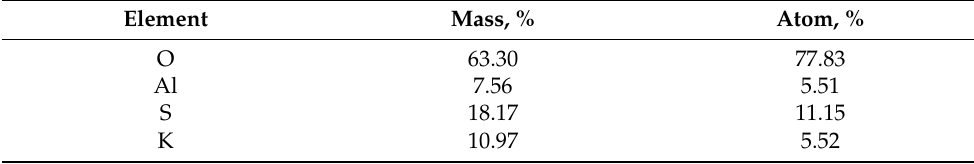
Table 2. EDX results—aluminium potassium alum.